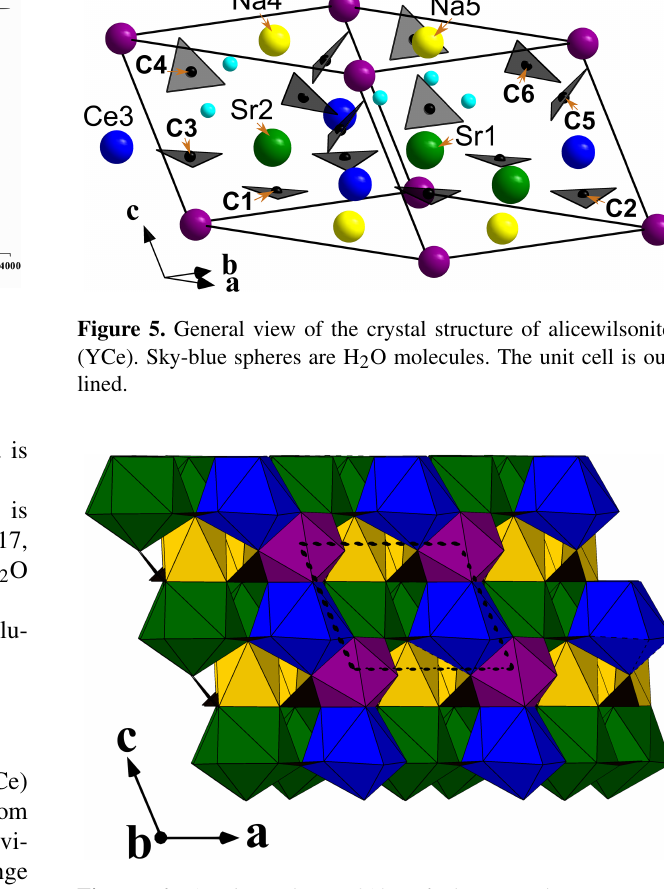
Figure 6. A view along [010] of the crystal structure of alicewilsonite-(YCe). Sr-, Ce-, Y-, and Na-centred polyhedra are shown in green, blue, purple, and yellow, respectively. Carbonate groups are black triangles. The unit cell is